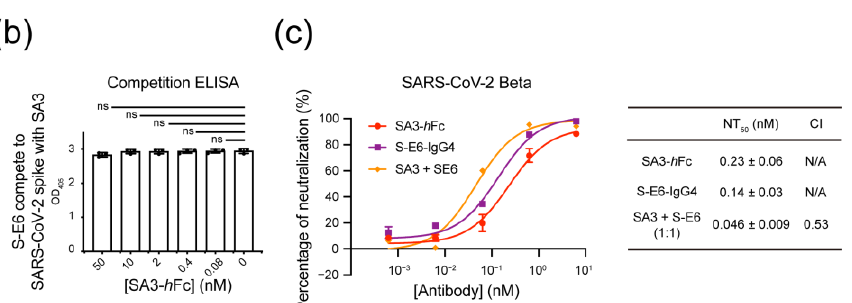
Figure 4. Mutually non-exclusive binding and synergistic neutralization activities of SA3 and S-E6. ( a ) Dose-dependent neutralization of SA3- h Fc and S-E6-IgG4 against WT and variant PSVs. Apparent NT 50 values are summarized in the table. ( b ) Competitive binding of S-E6-IgG4 to S-trimer-His in the presence of indicated concentrations of SA3- h Fc by ELISA. OD 405 values were measured and plotted in triplicates ( n = 3). ( c ) Percentage neutralization of S-E6-IgG4 and SA3- h Fc either alone or in a 1:1 combination against SARS-CoV-2 Beta PSV at various testing concentrations. The combination index (CI) value at NT 50 was calculated using the CompuSyn program. CI < 1 is defined as synergism. All the dose-response curves were measured in triplicates ( n = 3). The apparent NT 50 values were determined by Hill analyses using one-way ANOVA in GraphPad Prism.